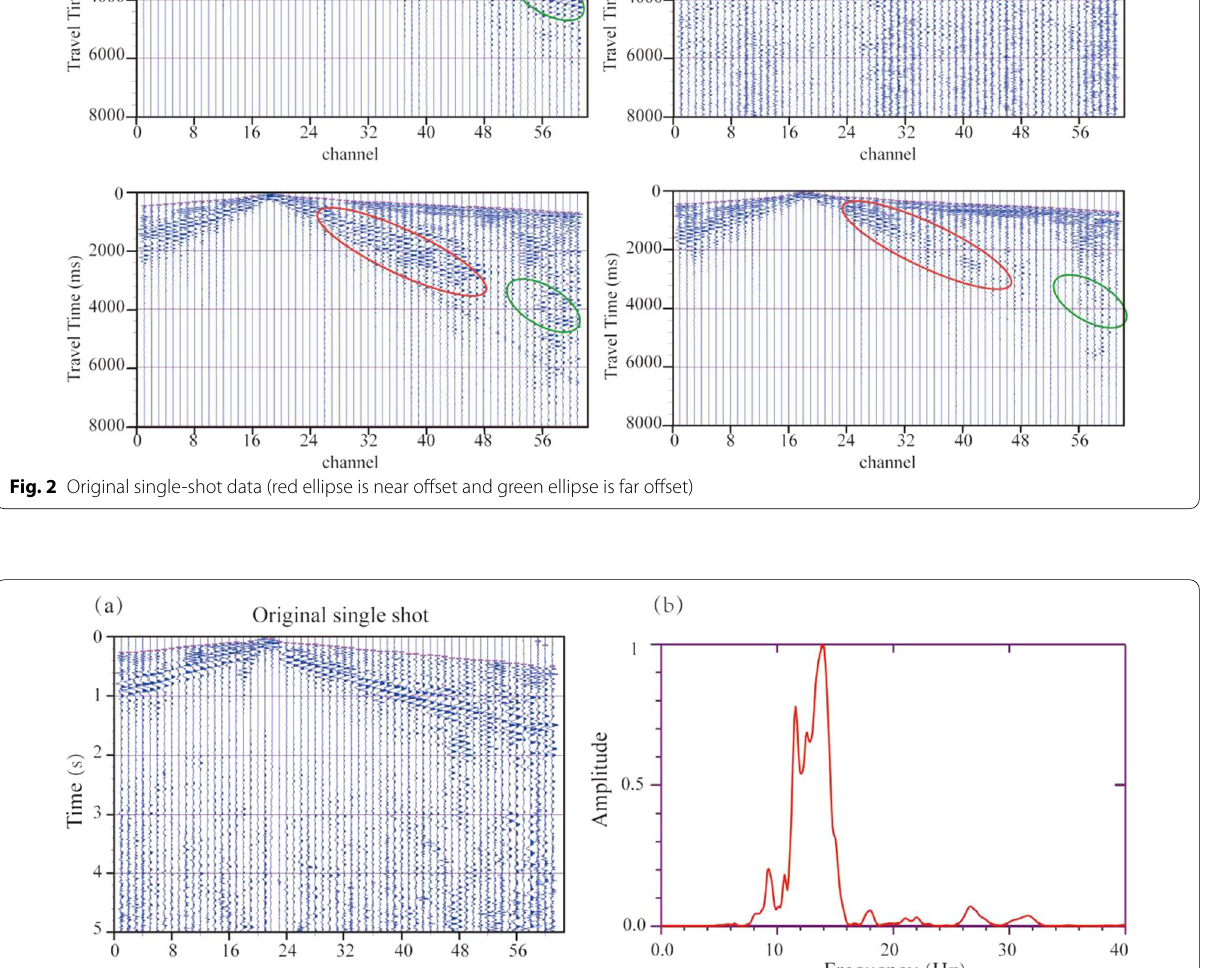
(Fig. 4c): the energy of the low-frequency part (2–4 Hz) of the fundamental-mode dispersion is weak, but the energy of the high-mode dispersion is strong. It is dif- ficult to accurately identify the dispersion curve in the high-frequency and low-frequency parts. (4) Unilateral 20-channel reception (Fig. 4d): the fundamental mode and the high mode of the low-frequency part are com- bined, which is difficult to distinguish. Therefore, it is dif- ficult to accurately extract the dispersion curve. Through the comparison of different reception methods and dif- ferent channels, we adopted 60-channel bilateral recep- tion to extract the dispersion curves. This can improve